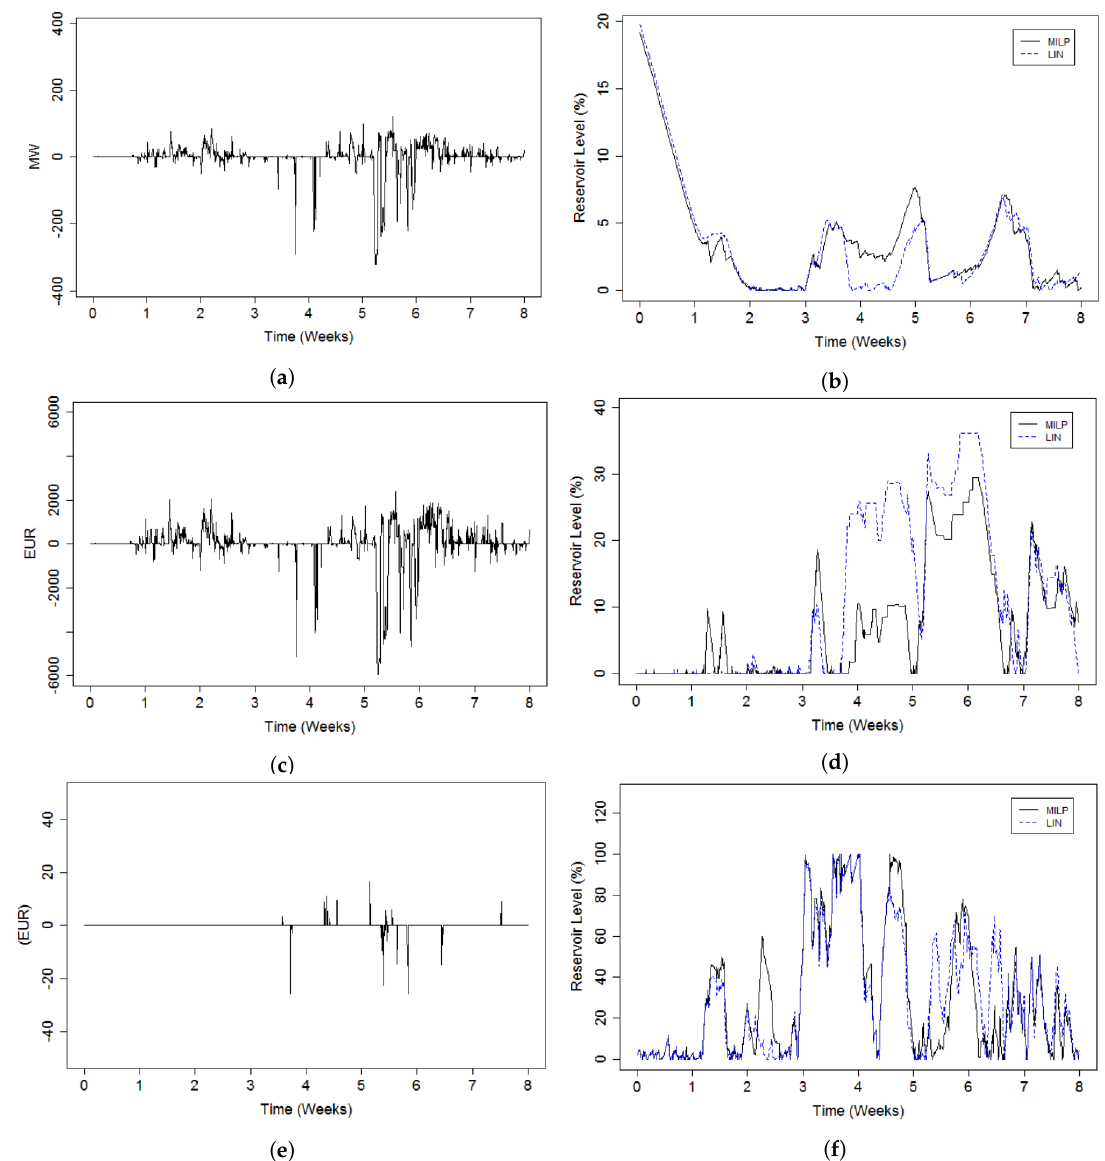
Figure 5. Hourly differences (MILP-LP) in committed volumes ( a ), revenue ( c ) and penalties ( e ). Reservoir profiles for reservoirs in the upper, left part of Figure 2, namely Nåvatn ( b ), Skjerkevatn ( d ) and Ørevatn ( f